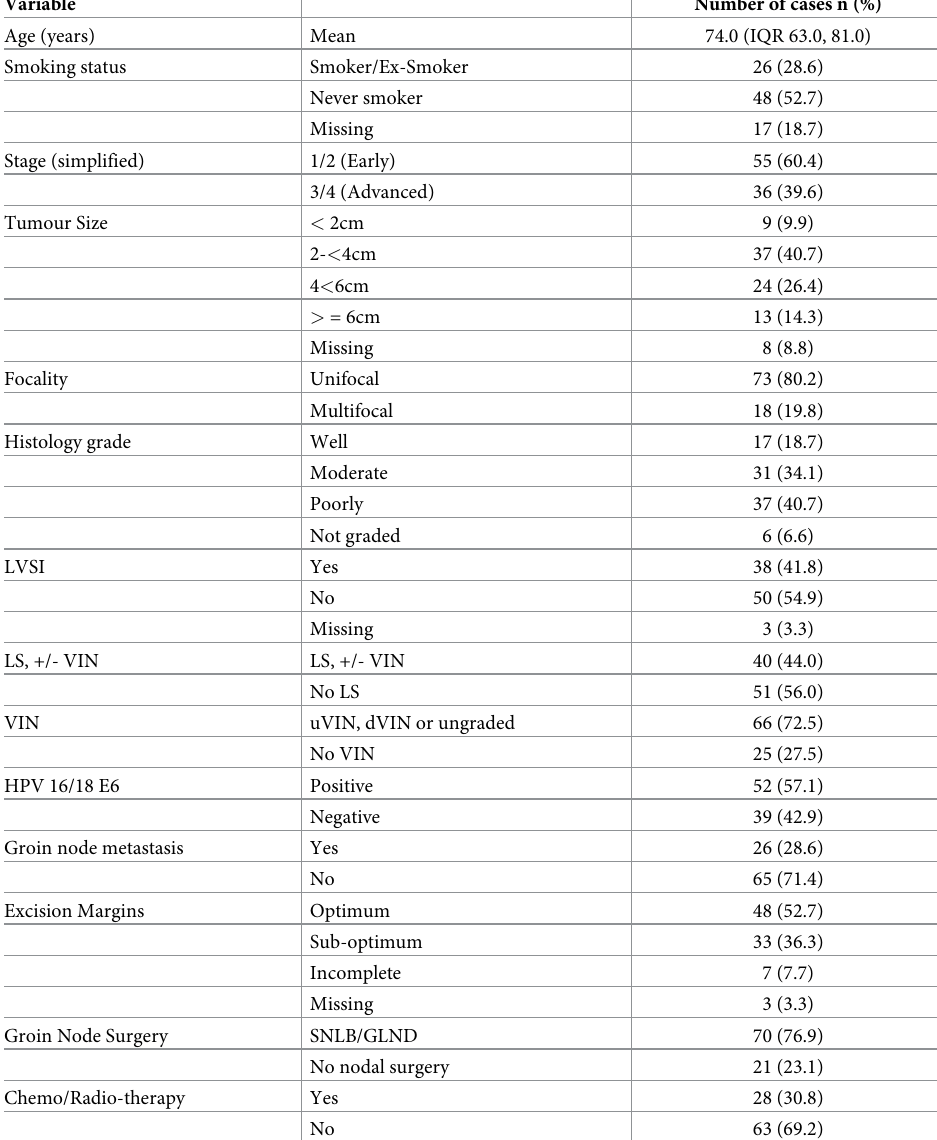
Table 1. Distribution of clinicopathological variables in the Birmingham VSCC